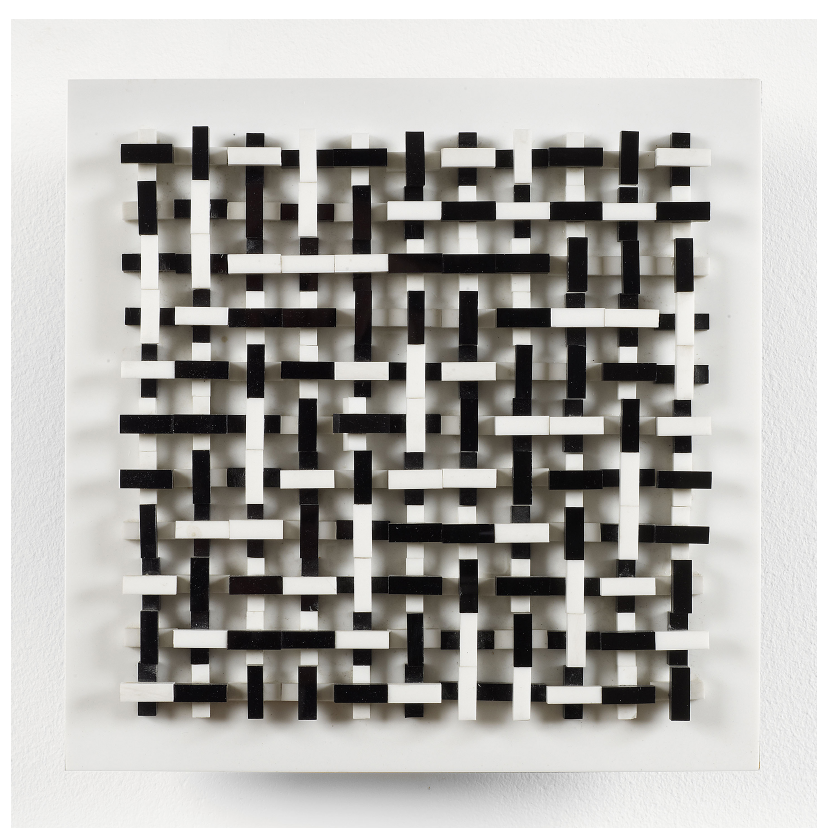
Figure 2: Peter Lowe, Permutations of Rows , 1968. Black and white Perspex on wood 25 x 25cm, Courtesy of Waterhouse Dodd,